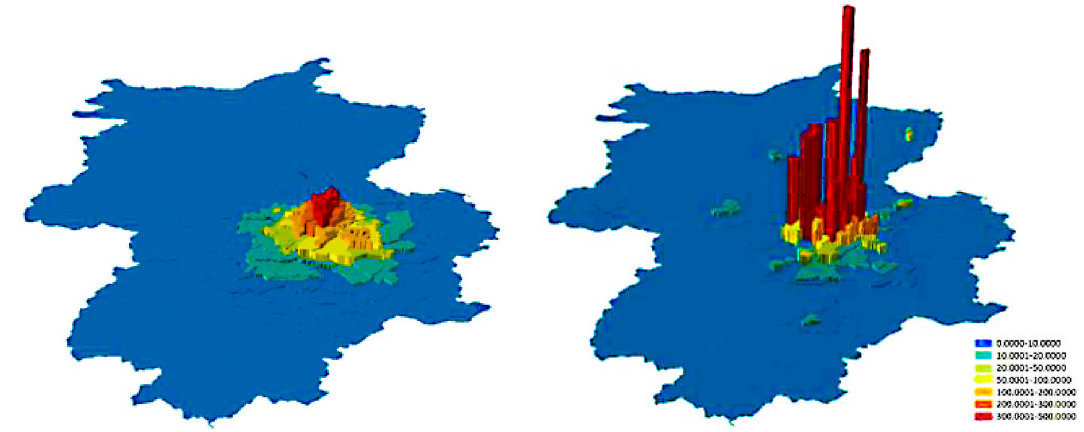
Fig. 5 Urban rail transit development and the change in employment spatial distribution (2000–2010)